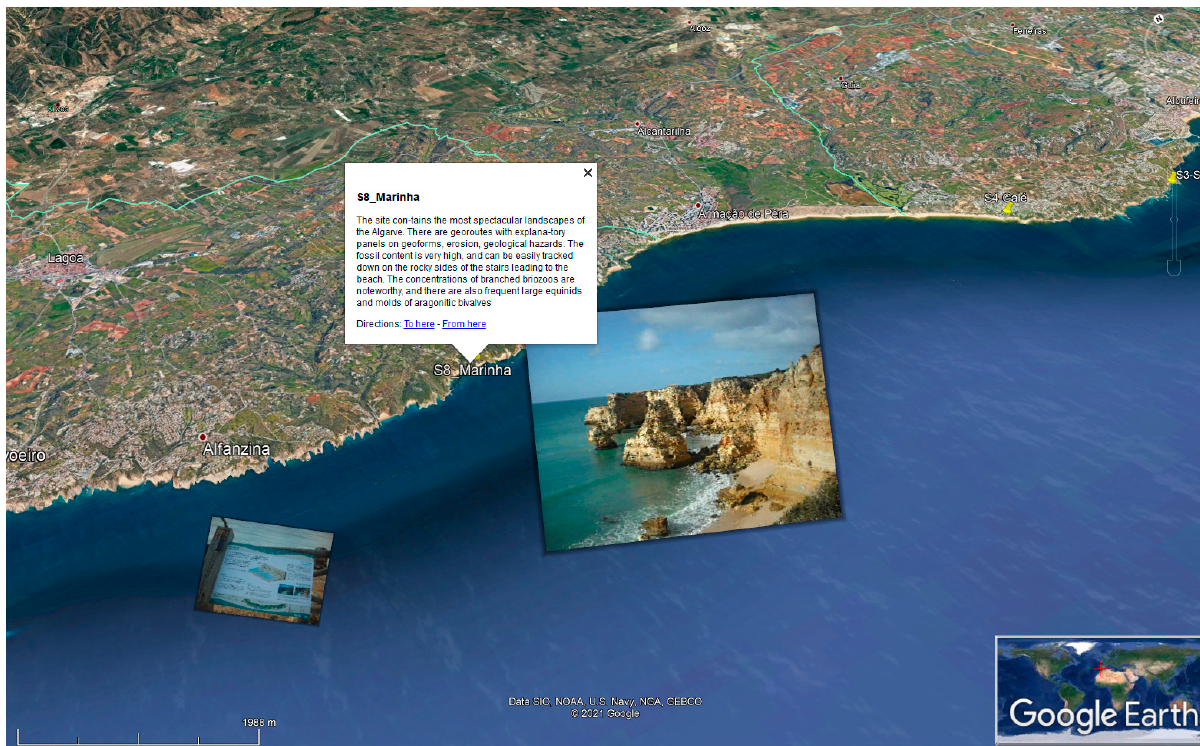
Figure 3. Capture of the geosites of Algarve, which shows the different thematic layers that can be obtained in the itinerary of the geological-geomorphological heritage: thematic cartographies, 3D relief models, block diagrams, diagrams and pho- tographs.